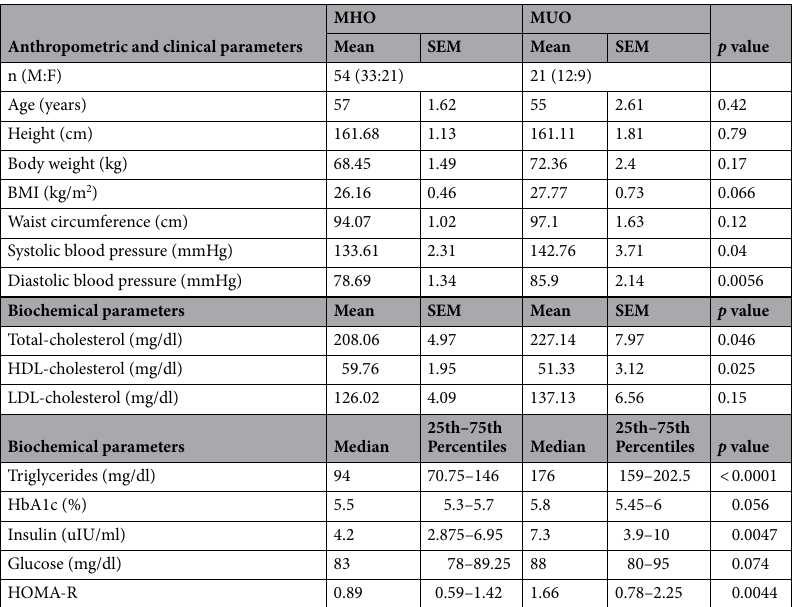
Anthropometric and clinical